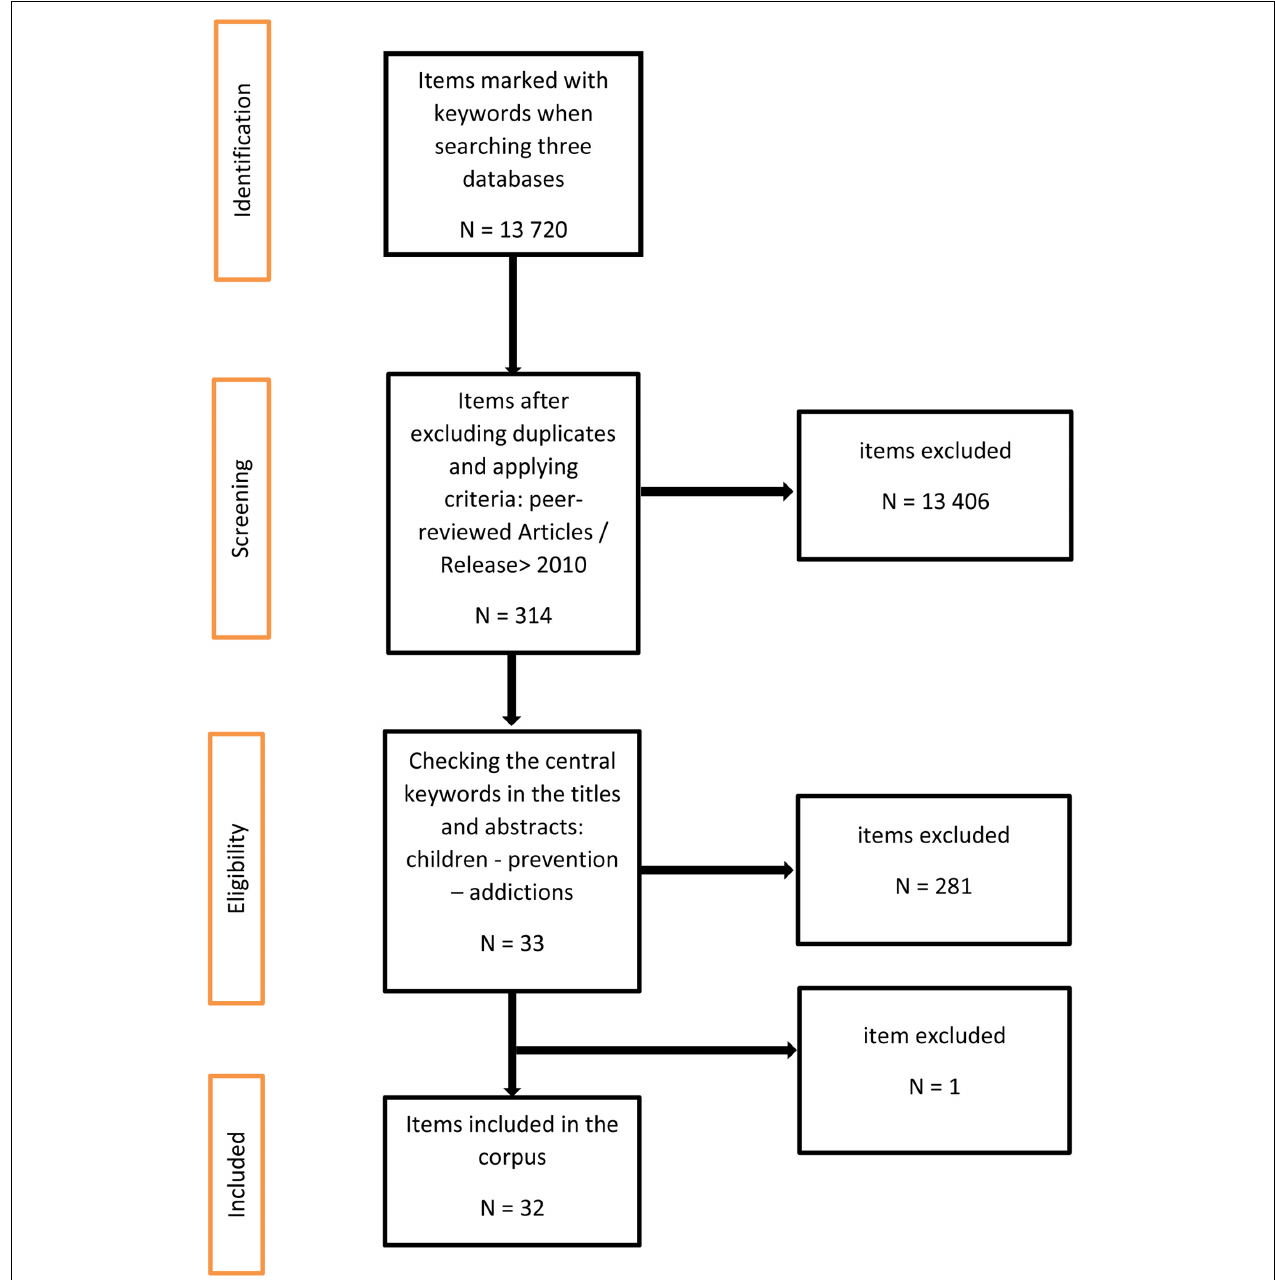
FIGURE 1 | Article review flow